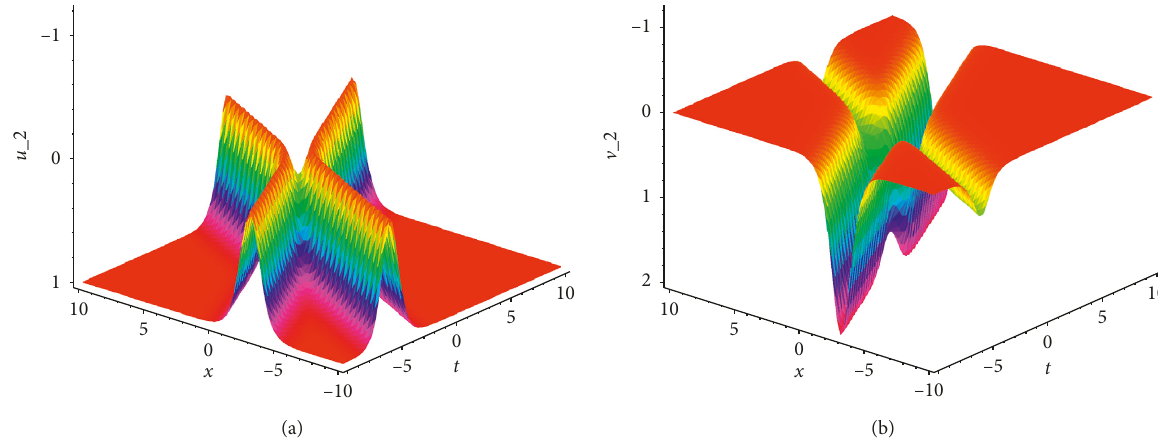
Figure 2: Interactions of two-resonant solitons expressed by equation (36) for solution of the nKdV equation (1) with the parameters a � ε � c � c � k � 1 and k � 1/2 . 1 2 1 2